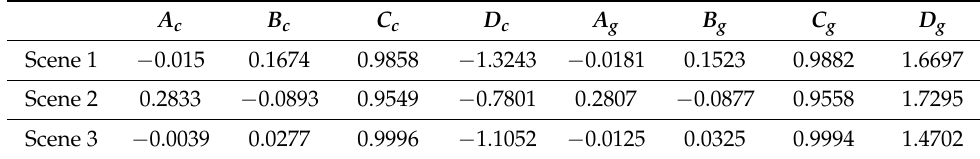
Table 8. Fitting the parameters of the ceiling and floor equations.